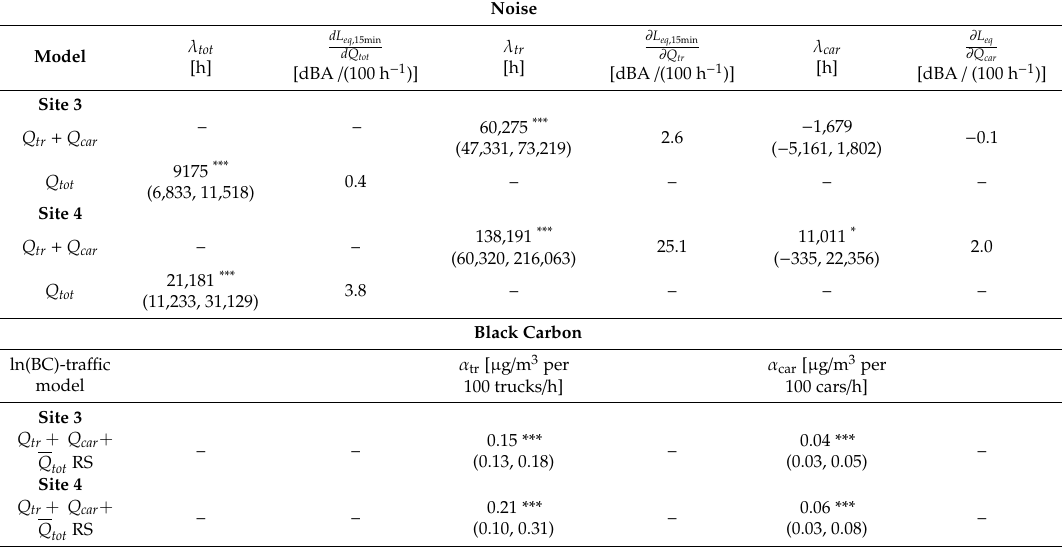
Figure 4. Predicted values for increases in truck (teal) and total vehicle (pink) flow due to the opening of an online grocery delivery service warehouse, from our interrupted time series (ITS) models (dashed lines) and the environmental assessment (EA) form submitted by the delivery service before construction (solid lines), separated by site and weekend vs. weekday. Gray error bars for the ITS points represent the mean +/ − the standard error. Total vehicles include both cars and trucks. Table 4. Mobile source contributions to noise and black carbon. Confidence intervals are given in